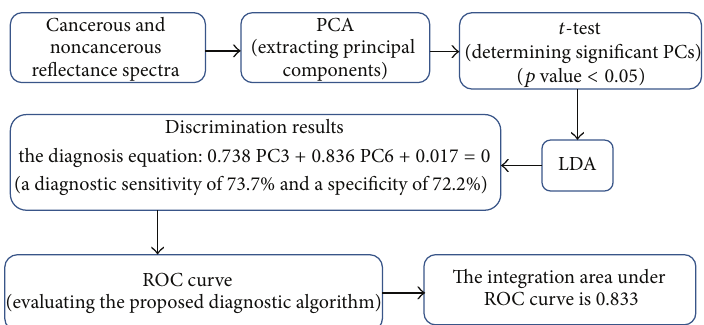
Figure 3: The work flowchart of multivariate statistical analysis.